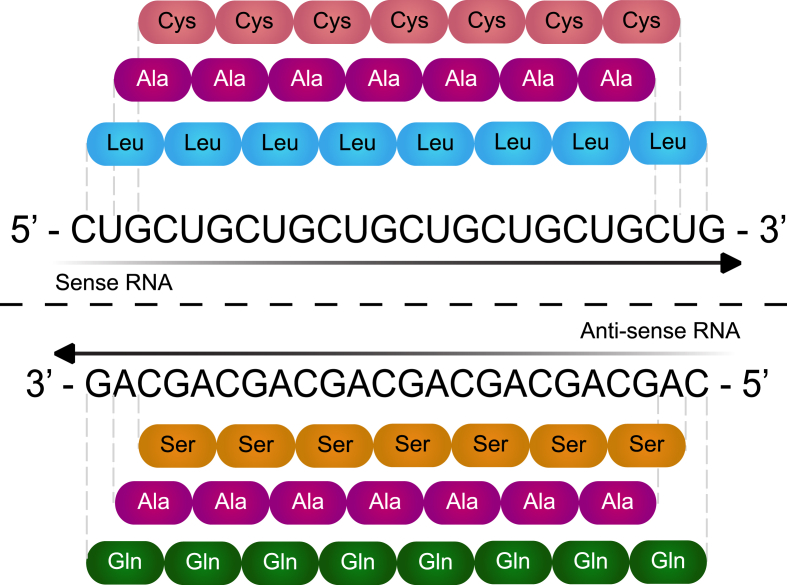
Poly-peptide proteins potentially translated from CTG18.1 expansions. Illustration of the potential repeat peptides that may be generated by repeat-associated non-AUG (RAN) translation from expanded (CUG)n RNA transcripts. The sense strand sequence may generate poly-Leucine (Leu), poly-Alanine (Ala) and poly-Cysteine (Cys) peptides and the antisense strand sequence may generate poly-Glutamine (Gln), poly-Alanine (Ala) and poly-Serine (Ser) peptides.